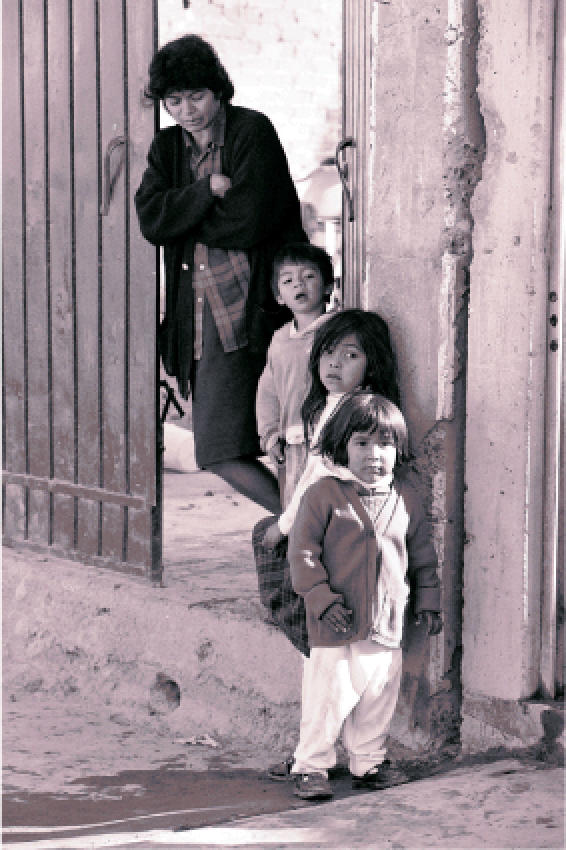
In many countries, the health of women and children is linked with their economic and social status(Photo: Rick Maiman, on behalf of the David and Lucile Packard Foundation)